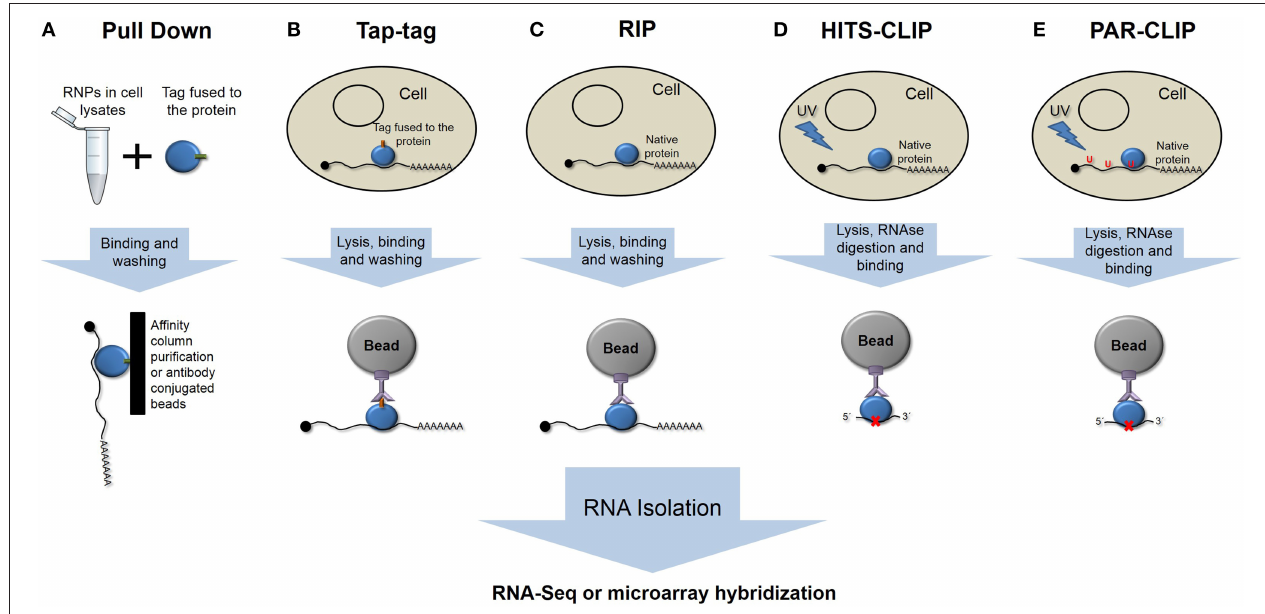
FIGURE 1 | Schematic representation of the different main ribonomic strategies. (A) RNA pulldown in vitro purification. (B) Tandem affinity purification of tagged proteins. (C) RNA-protein immunoprecipitation. (D) High-throughput sequencing of RNA isolated by crosslinking and immunoprecipitation. (E) Photoactivatable-ribonucleoside- enhanced crosslinking and